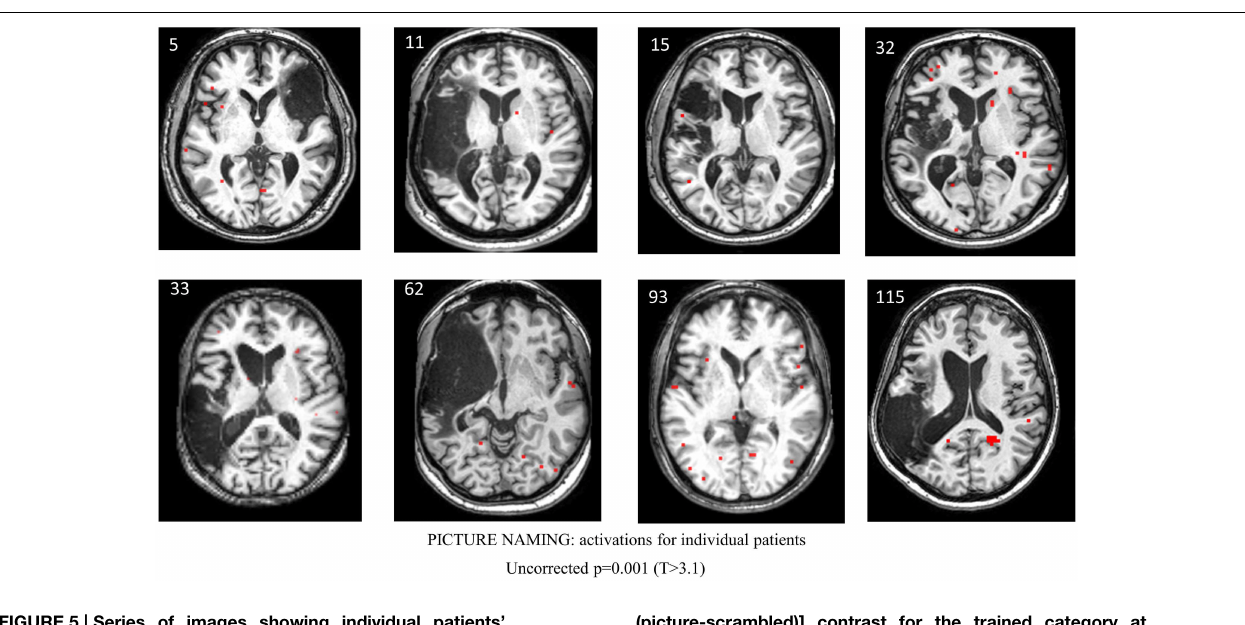
(picture-scrambled)] contrast for the trained category at p = 0 . 001 uncorrected. Voxels above a threshold of T > 3 . 10 are